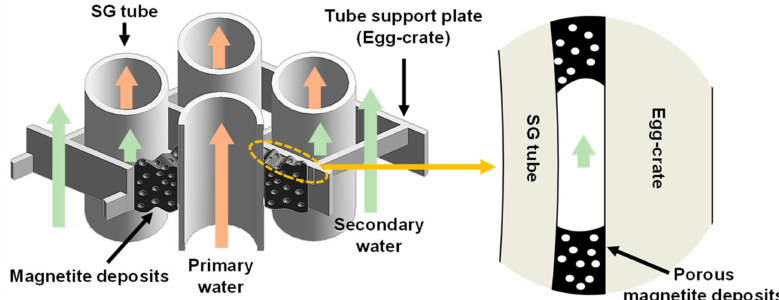
Figure 1. Schematic of the secondary flow path between the steam generator (SG) tube and their support plat and tube support plate (TSP) blockage owing to the magnetite